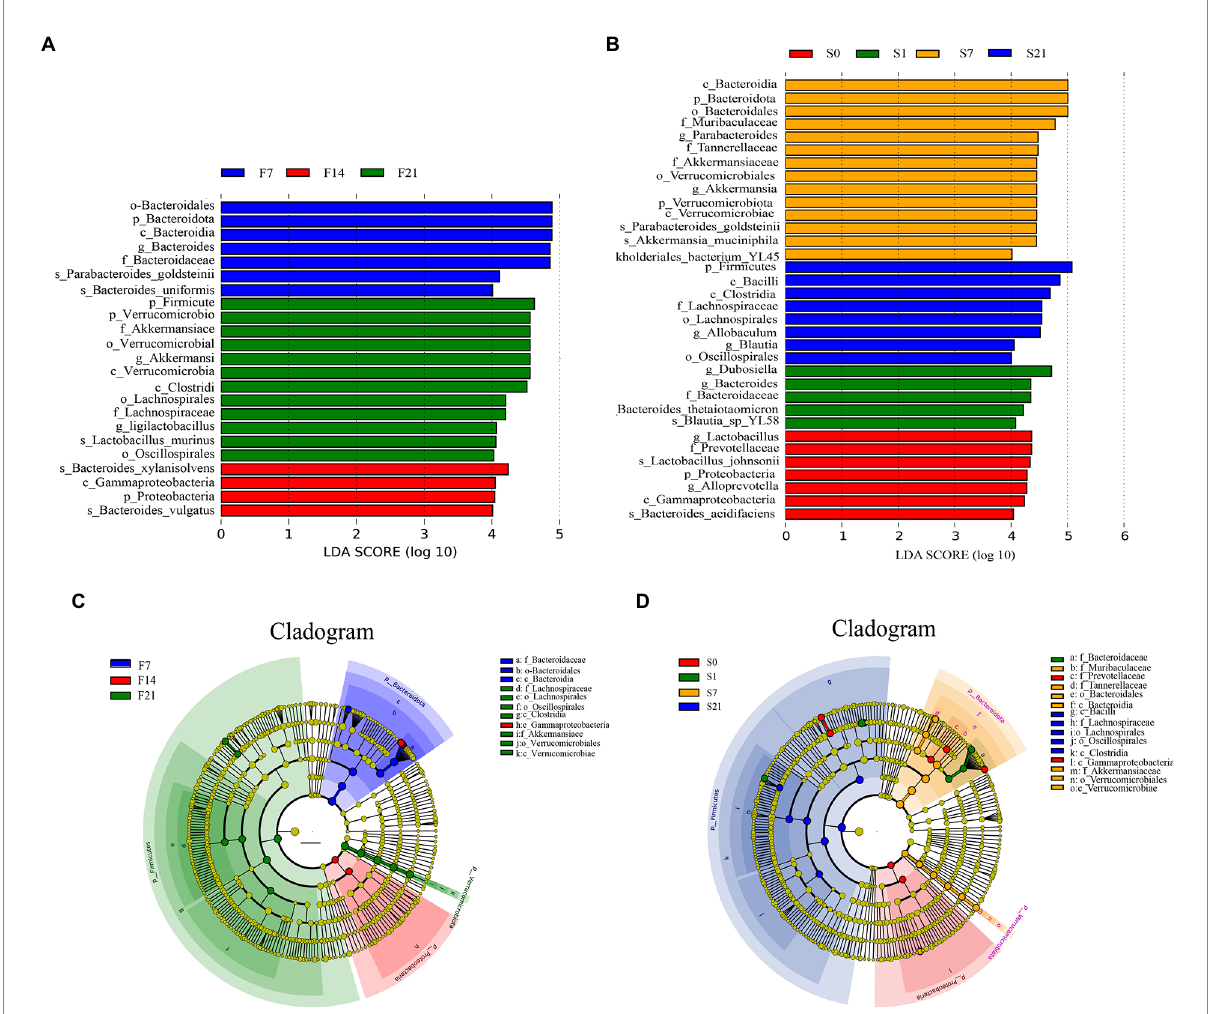
FIGURE 7 Linear discriminant analysis Effect Size analysis of intergroup differences in community structure. (A) Bar chart of LDA score distribution in GF mice; (B) Bar chart of LDA score distribution in SPF mice; (C) Cladogram of GF mice; (D) Cladogram of SPF mice. GF, germ-free; LDA, linear discriminant analysis; LefSe, Linear discriminant analysis Effect Size; SPF, specific pathogen